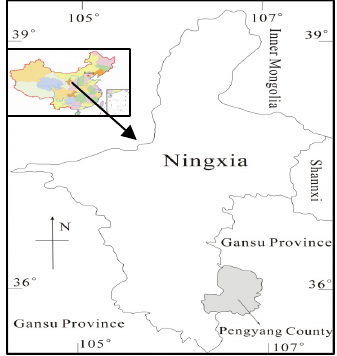
Figure 1. Location of the study area